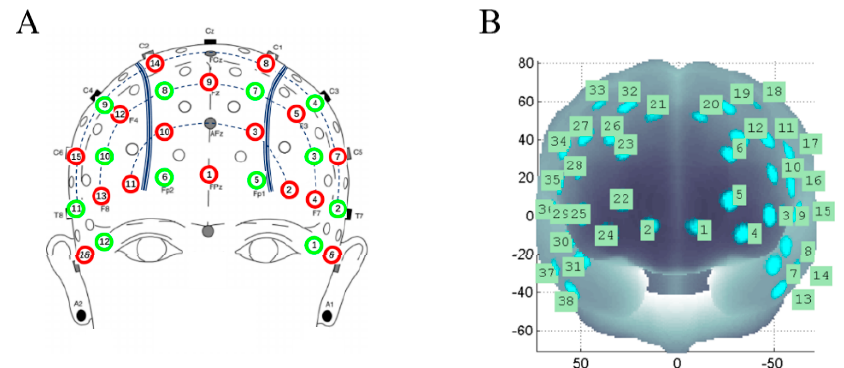
Figure 2. Location of the functional near-infrared spectroscopy (fNIRS)